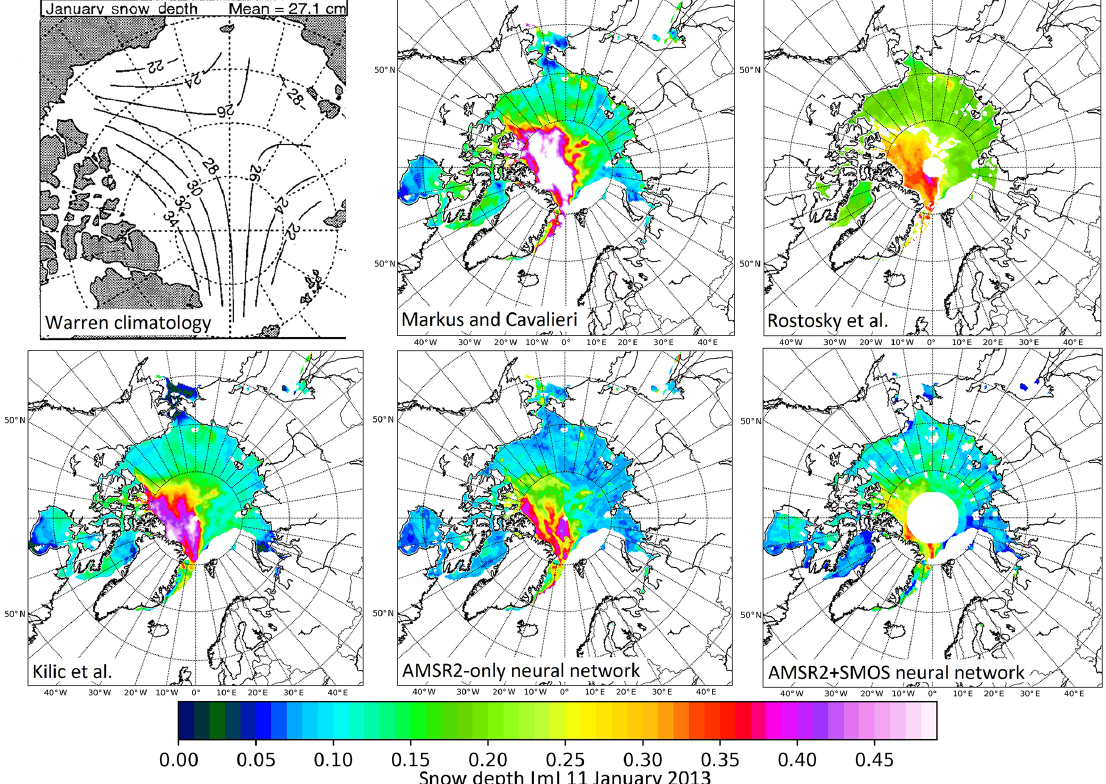
Figure 7. Map of Arctic snow depth on 11 January 2013 estimated with different